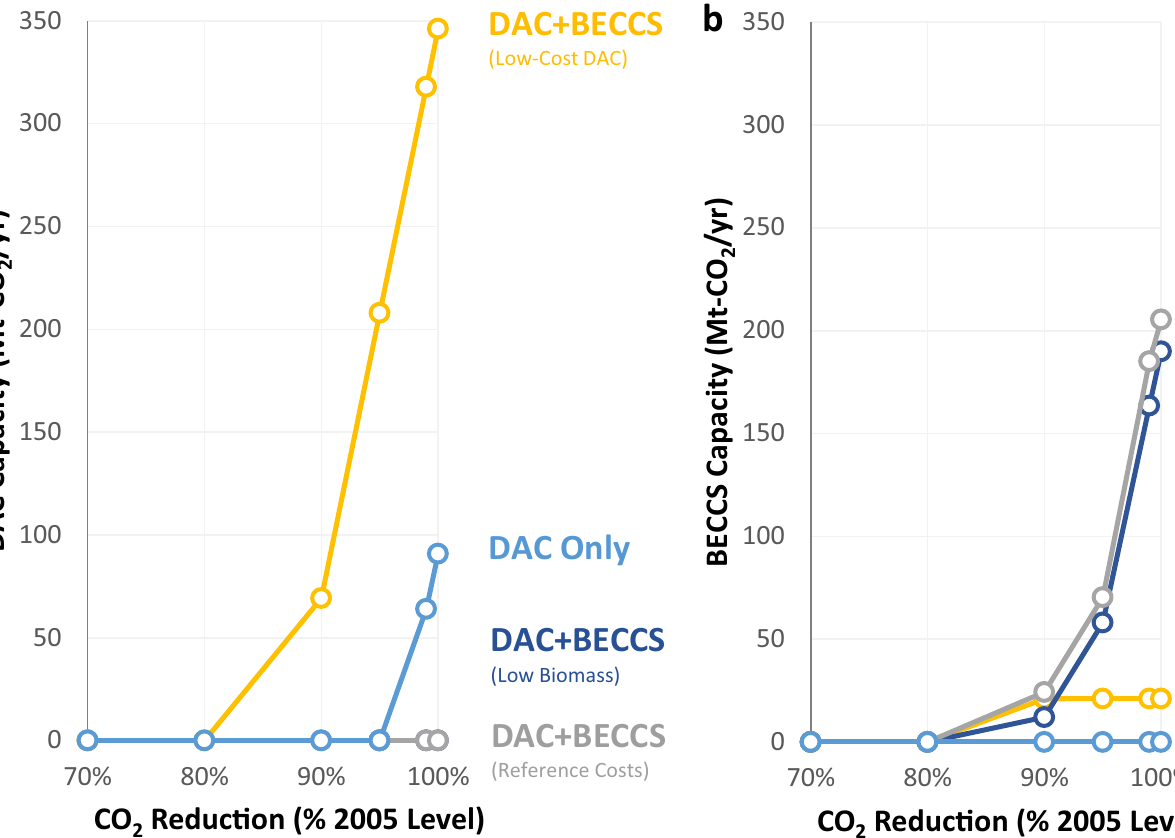
CO Reduc(cid:2)on (% 2005 Level) 2 Fig. 2 CO 2 removal capacity by electric sector CO 2 reduction level (% 2005 levels) and CDR availability scenario. Panels show capacity for DAC ( a ) and BECCS ( b ). Scenario assumptions are described in the “ Methods ” section. Results are outputs from the REGEN model 23 detailed in the “ Methods ” section and Supplementary Note 1. Source data are provided as a Source Data fi